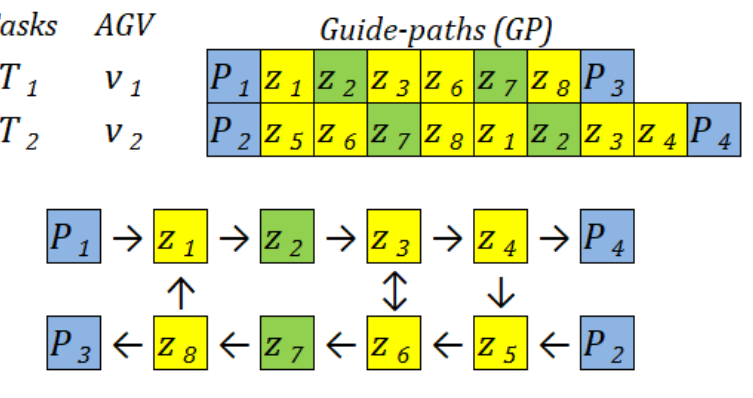
Figure 2. An example of a transportation